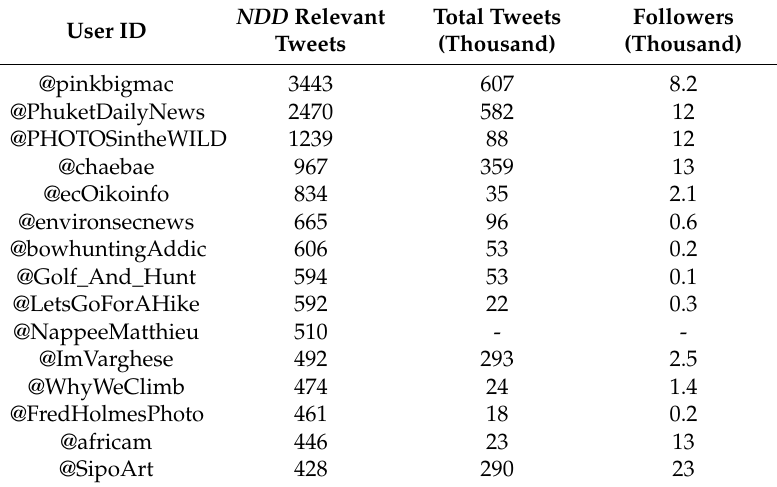
Table 12. Most publishing